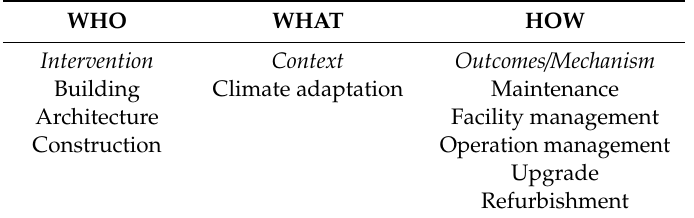
Table 2. Keywords, Boolean operators, and search